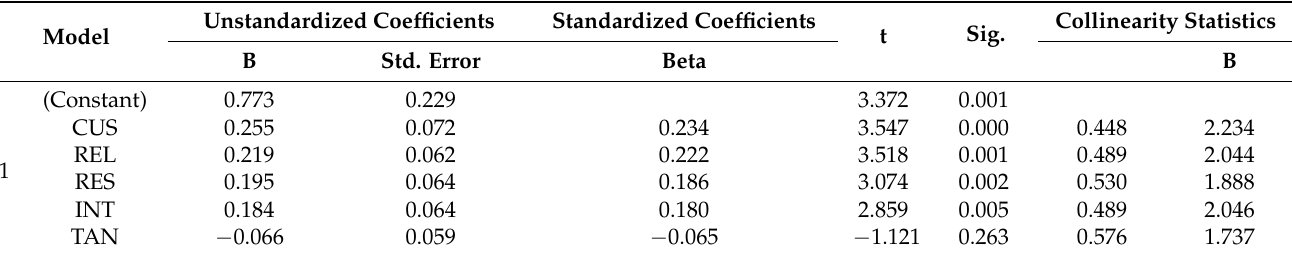
Table 11. Linear regression